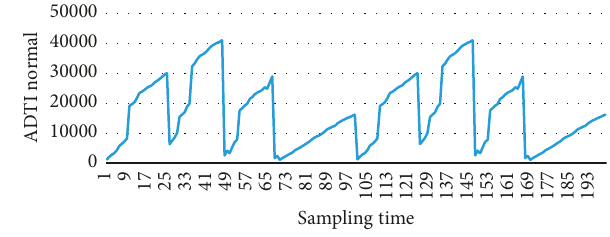
Figure 14: Feature of VPI for normal traffics.